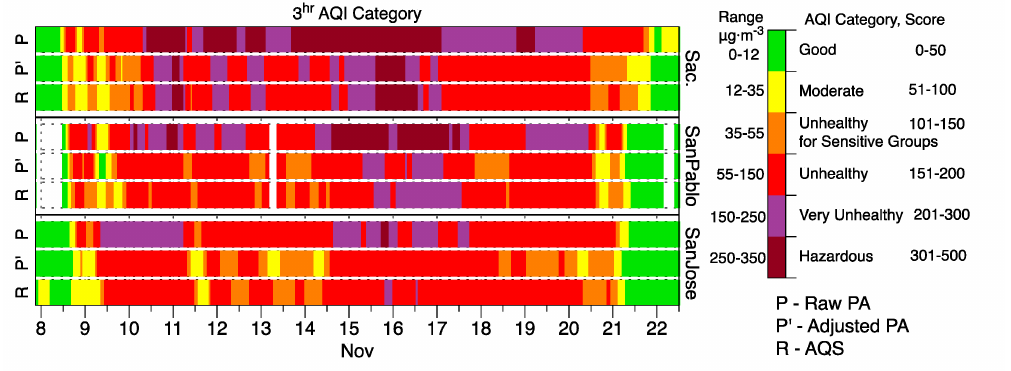
Figure 10. Comparison of Air Quality Index (AQI) values calculated using unadjusted data from PA-II monitors and the same data after correction with the regional, event specific AF to AQIs from PM 2.5 data at regulatory monitoring sites in Northern California during Camp